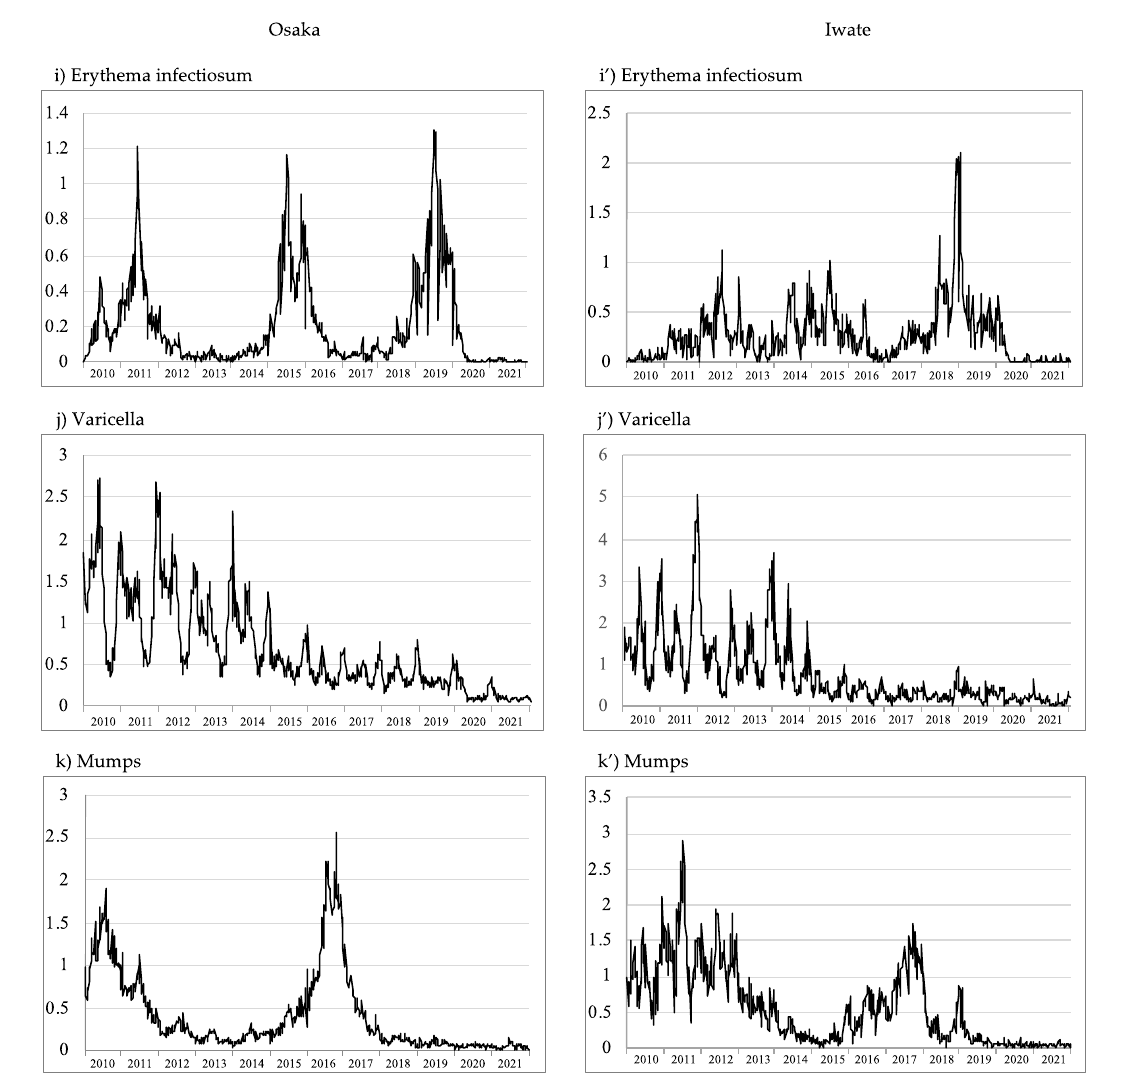
Figure 1. Trends in weekly reported cases of infectious diseases per sentinel site from 2010 to 2021 in Osaka and Iwate prefectures. The 11 diseases were reported mainly among pediatric